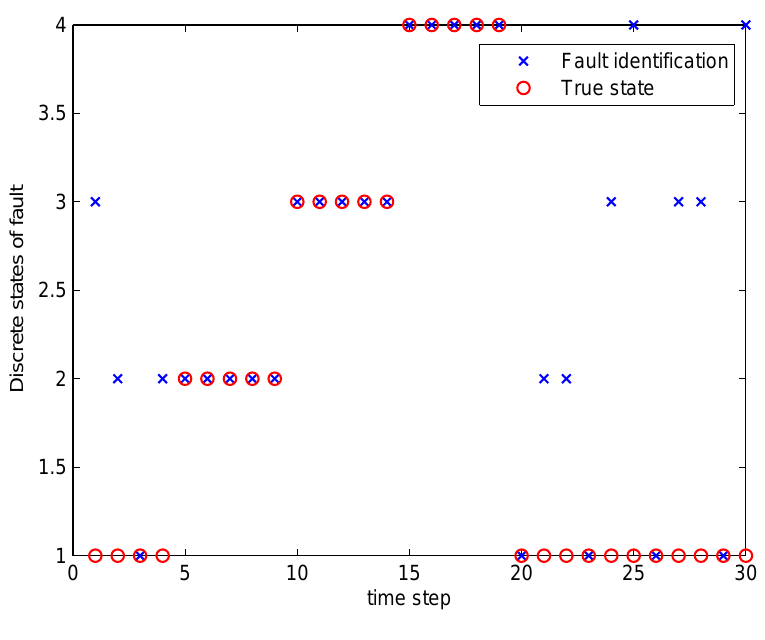
Figure 4. Fault diagnosis